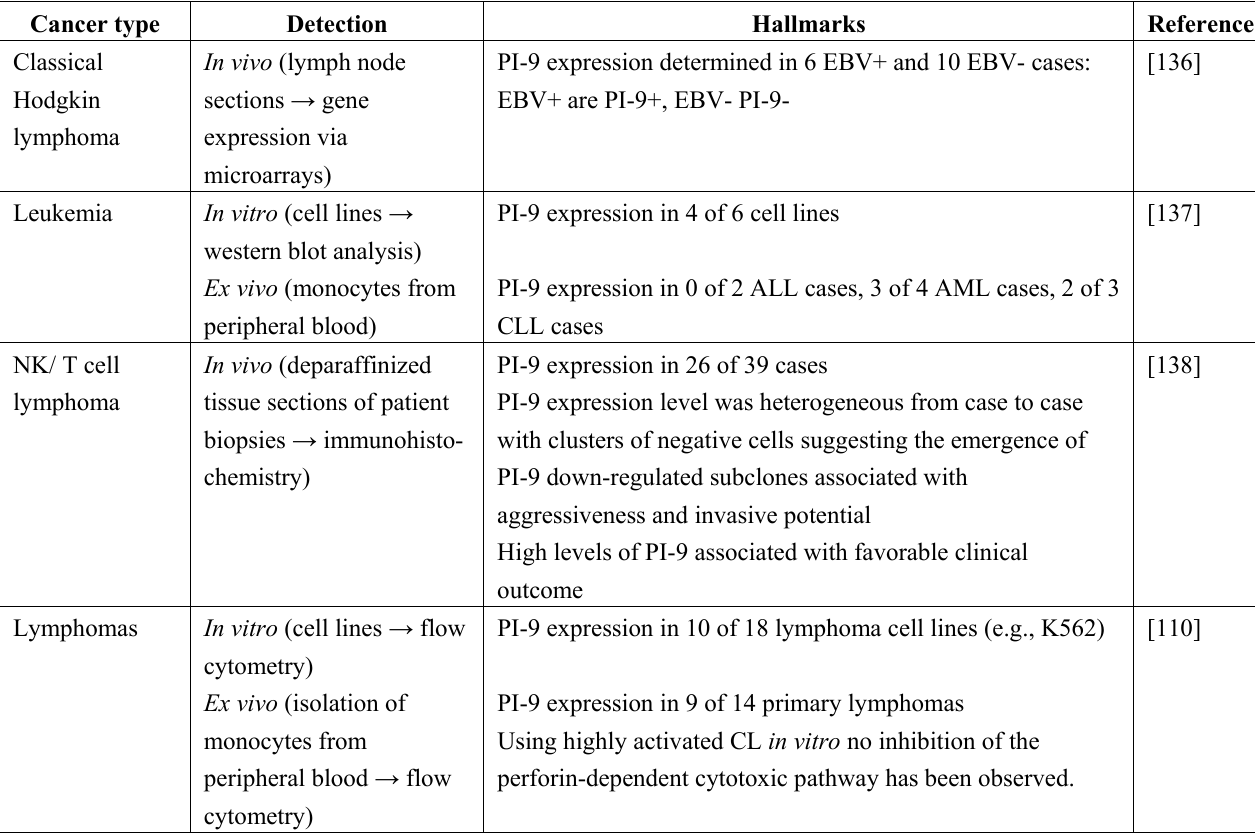
Table 4. Overview of PI-9 expression in different